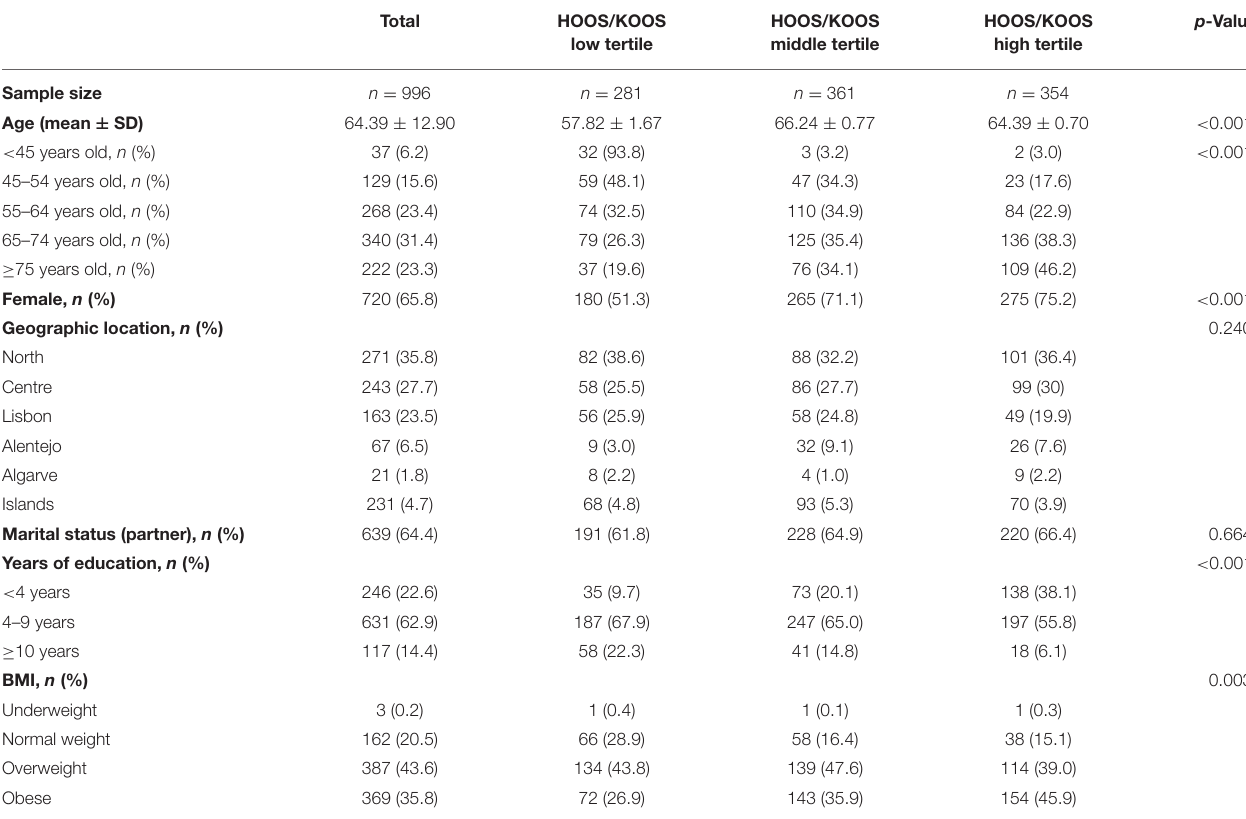
TABLE 2 | Sociodemographic and anthropometric characteristics of participants with HKOA by clinical severity. Total HOOS/KOOS low